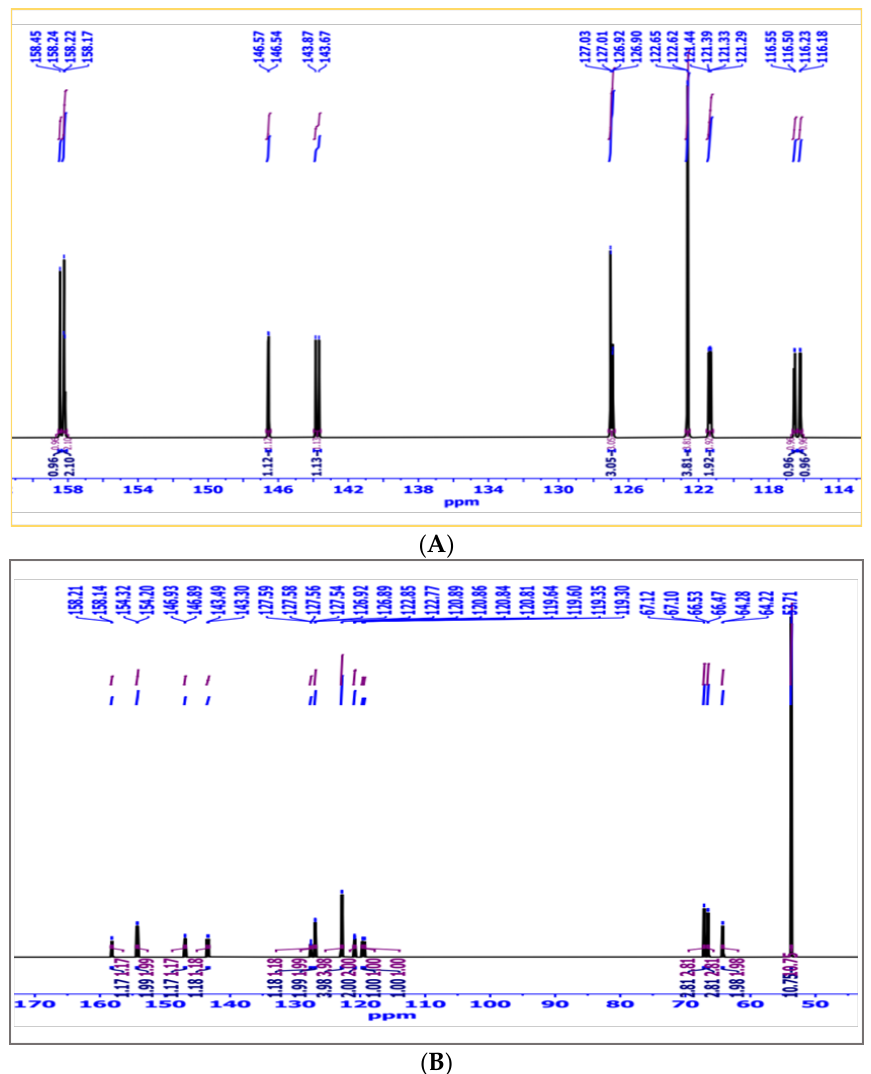
Figure 4. 13 C-NMR analysis of ( A ) HNAP and ( B ) HNAP/QA.